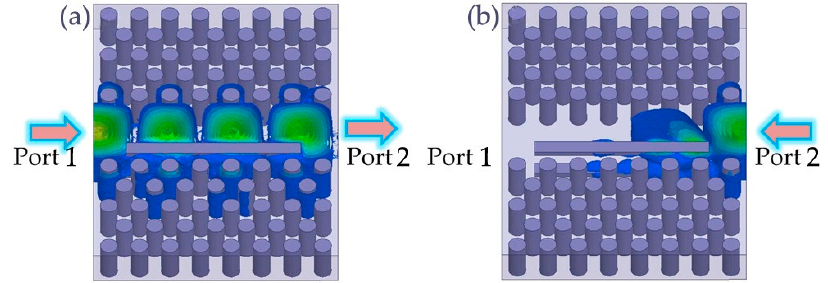
Figure 5. The function of the MO isolator at 26 GHz: ( a ) Electromagnetic field propagation from Port 1 to Port 2; ( b ) Electromagnetic field launched from Port 2 but Port 1 isolated.